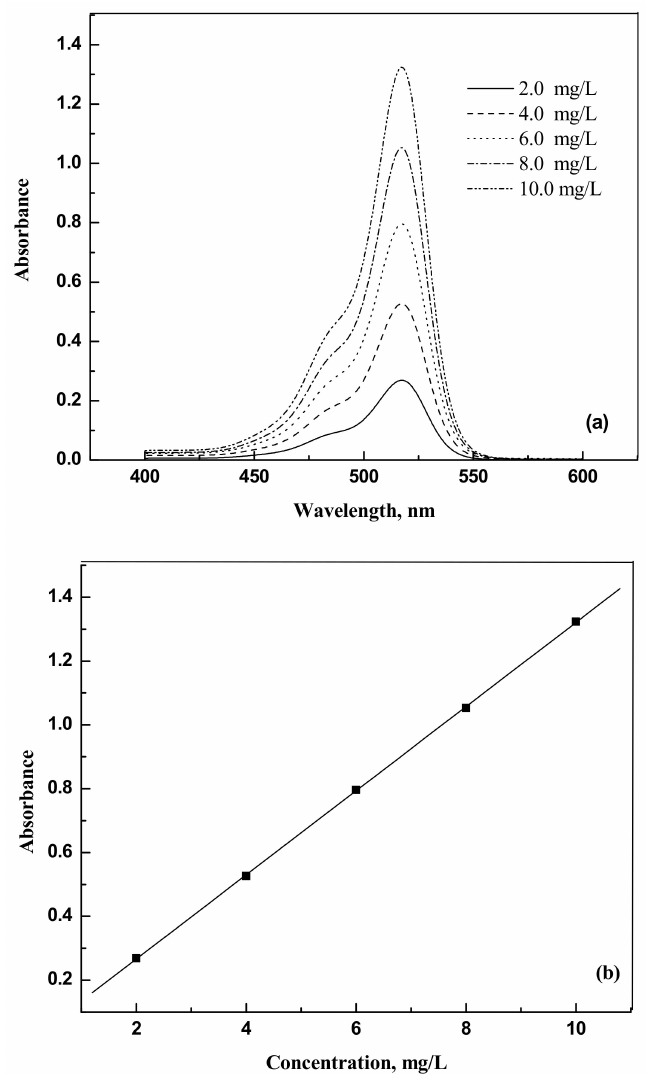
Figure 9. ( a ) Absorbance versus wavelength for eosin Y. ( b ) Absorbance versus concentration for eosin